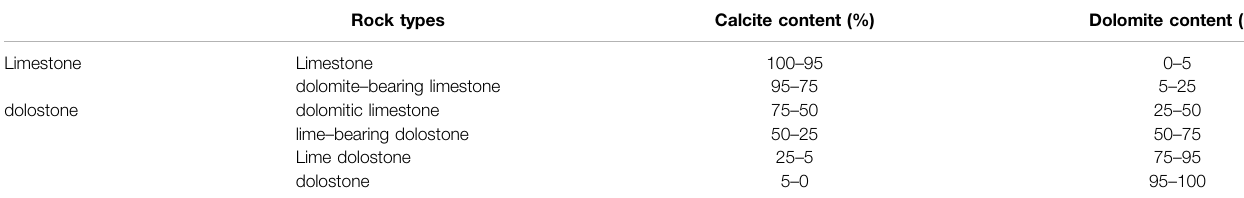
TABLE 1 | Carbonate rock type classi fi cation standard (Zhou, 1998).